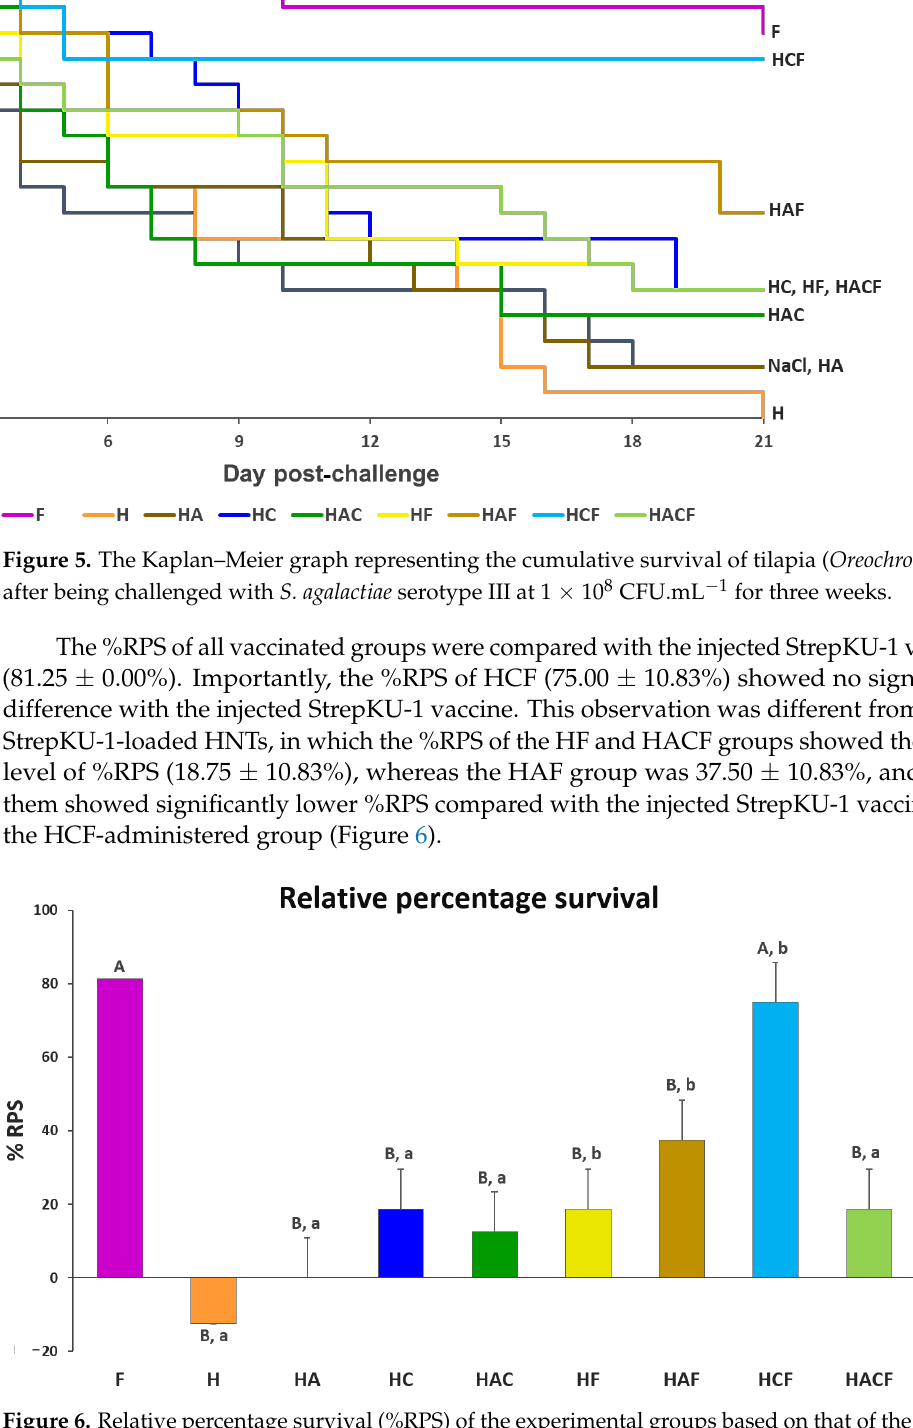
Figure 6. Relative percentage survival (%RPS) of the experimental groups based on that of the control NaCl group at 21 days post-challenge. Data are represented as the means ± SDs (n = 3; n represents three replicated aquarium tanks). Statistical analysis was performed via a paired two-sample t -test for an analysis of means with p < 0.05. The capital letters above the bars indicate the significant differences between the F group (StrepKU-1 injection) with others. Moreover, the small letters indicate significant differences between those with and without loading the StrepKU-1 for each pair of materials (H vs. HF, HA vs. HAF, HC vs. HCF and HAC vs. HACF).